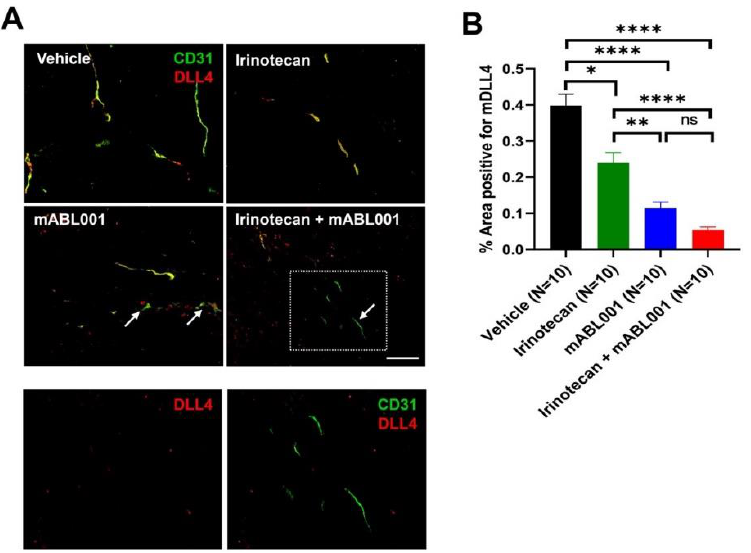
Figure 4. ABL001 significantly reduced DLL4 expression in tumor blood vessels. Representative immunofluorescence images ( A ) indicate the tumor vasculature in SW620 tumor tissues stained for CD31 (green) and DLL4 (red). The bottom figures ( A ) are magnified images of the dotted region of the combination treatment of mABL001 and irinotecan. The left image was shown only by red channel, whereas the right one was shown by merged channels (red and green). Similar to VEGFR-2, DLL4 was stained and colocalized on CD31 positive tumor blood vessels. The area density of DLL4 ( B ) positive vessels was measured in tumors of each group. Compared to vehicle or irinotecan treatment, DLL4 positive tumor vessels were significantly reduced in tumors after mABL001 or the combination treatment. Some tumor vessels were stained only for CD31 but not for DLL4, after mABL001 or the combination treatment group (arrows and dotted box in A). Scale bar indicates 50 µm in the bottom two images and 100 µm in the other images. Error bars: mean ± SEM. * p < 0.05, ** p < 0.01, **** p < 0.0001 by Kruskal–Wallis test.